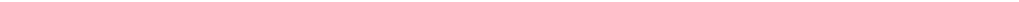
Fig. 3 Non-curative cyclophosphamide therapy induces accelerated disease progression in TC mice. Exposure of TC animals to four cycles of cyclophosphamide-based chemotherapy is insuf fi cient to cure the CLL that develops in these animals and instead results in a massive acceleration of disease progression, which is comparable to that observed in high-risk TCP and TCA animals. An acute response to cyclophosphamide treatment (200 mg/kg, i.p., once weekly, four injections), indicated by a decrease in the leukemic fraction (CD5 + /CD19 + of CD45 + /SS low ) a and the total leukocyte counts b , as well as an increase in platelet counts c was observed in all three lines ( n = 14 for each genotype, “ pre ” , one week before treatment initiation; “ post ” , one week after the fourth therapy cycle). d and e show spleen volumes of TC, TCA, and TCP animals ( n = 8, n = 5 and n = 5, respectively) before and 1 week after treatment. f Survival after treatment initiation for TC, TCA, and TCP. g Percentage of CD5 + /CD19 + lymphocytes plotted over time. Shown are representative animals of all three lines. Dashed red areas mark the period of cyclophosphamide treatment. The data points before and after treatment were fi tted linearly, with the slope indicating the change of the leukemic fraction in the peripheral blood over time (percent points/week). h Averages of the change of the leukemic burden over time before and after treatment (10 animals/line). The individual time course plots are shown in Supplementary Fig. 7. i Fold increase of disease progression after treatment ( n = 10 animals/line). j Changes in the allelic fraction over time of TP53 mutations in two CLL patients. Dashed areas mark the period of therapeutic intervention ( fl udarabine/cyclophosphamide, one cycle (patient #1) and four cycles (patient #2)). Whiskers represent minimum to maximum, error bars represent SEM. a , b , c , h Welch ’ s t -test for comparison between different genotypes. Paired t -test for comparison of pre- and post-treatment values within a cohort. f Log-rank test. * indicates p < 0.05, ** indicates p < 0.01, *** indicates p <